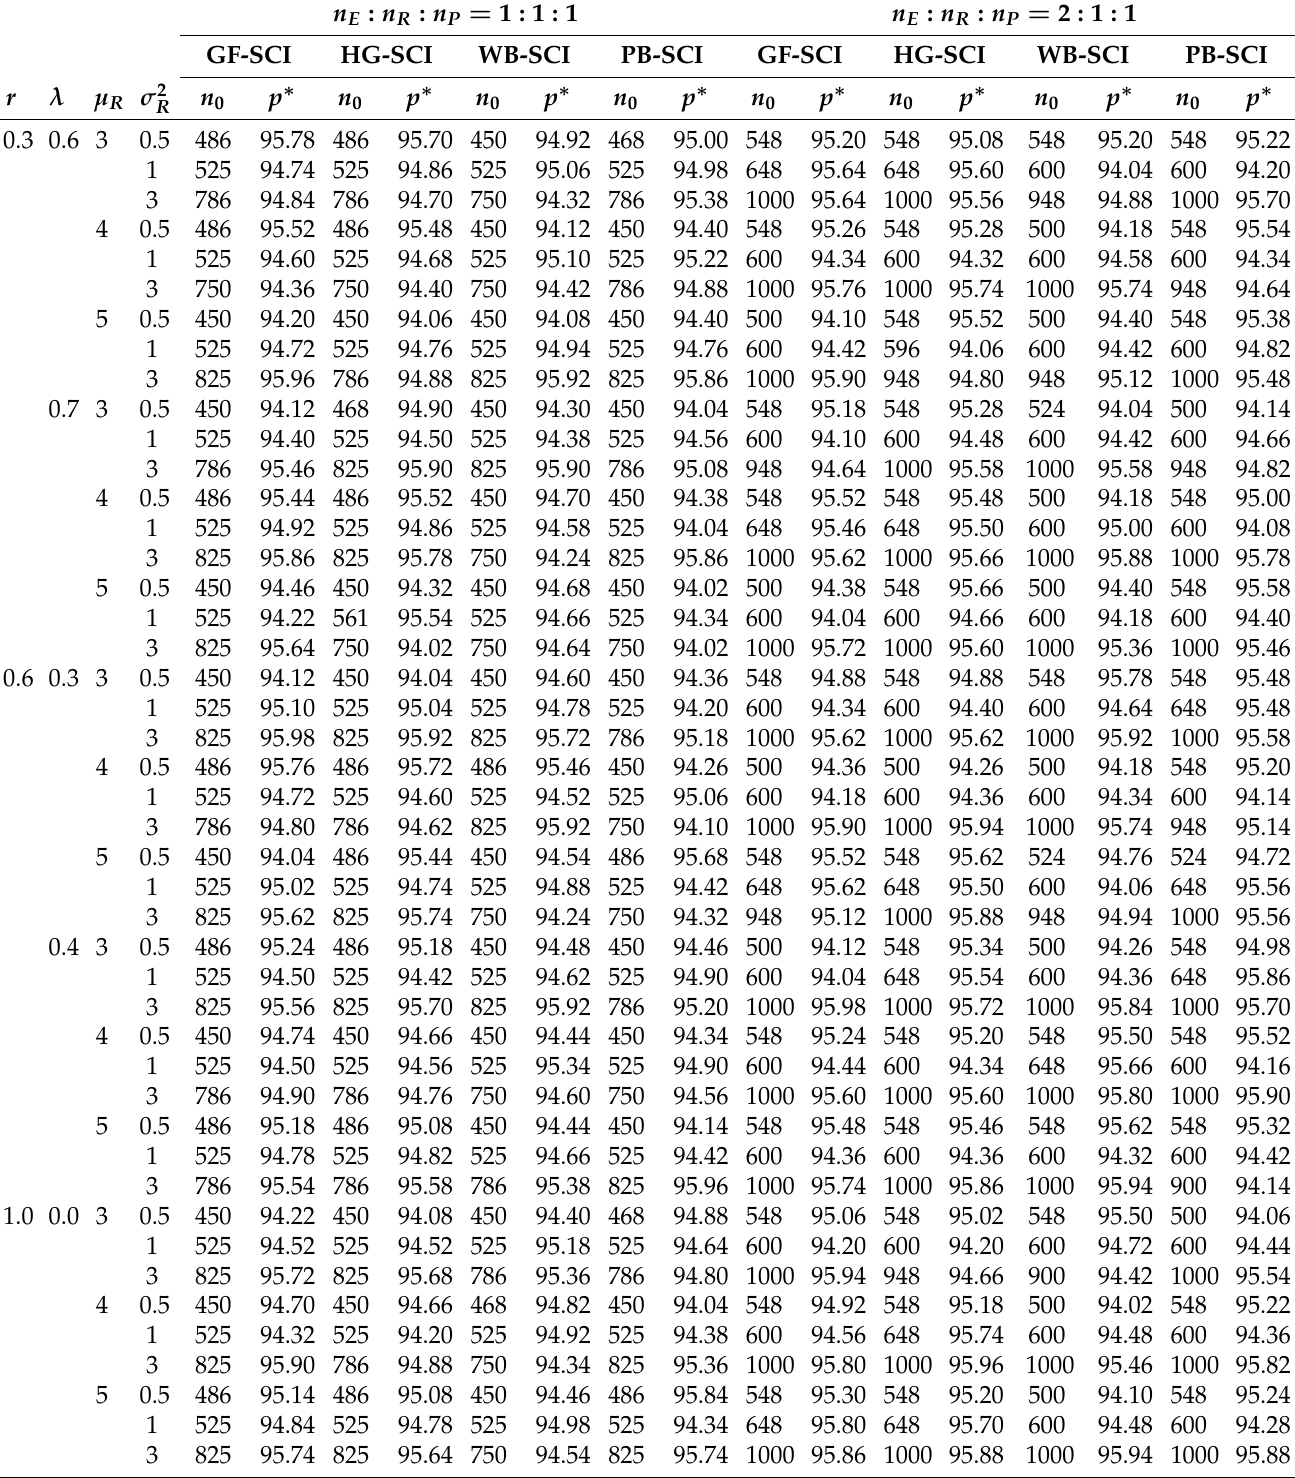
Table 4. The required sample sizes n for true power 1 − β = 95% and its empirical powers p ∗ under various settings with (cid:101) =